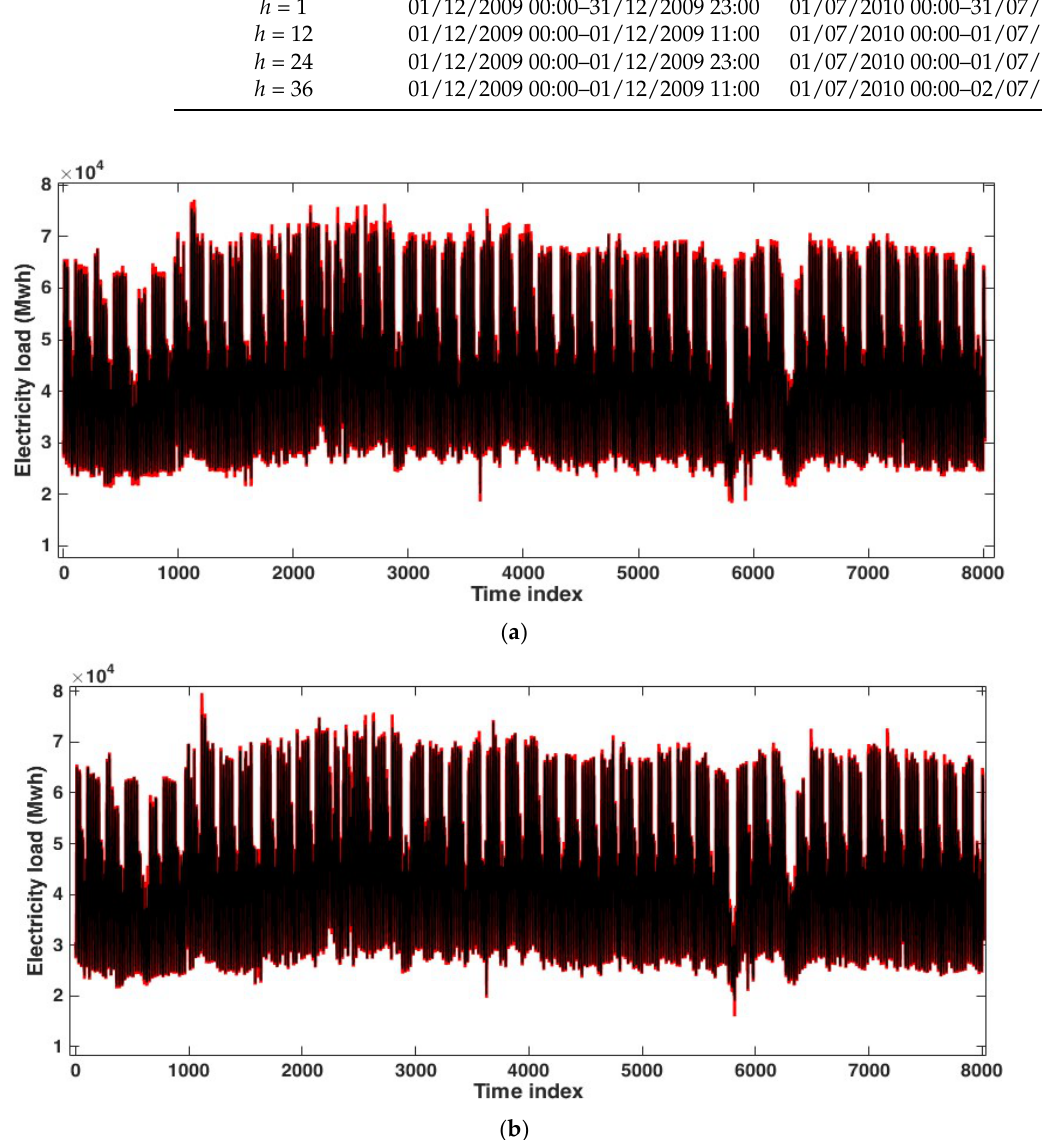
Figure 3. The original series (in black) and the bootstrap time series (in red) obtained by the ( a ) KM.N method; ( b ) SSA.KM.N method.